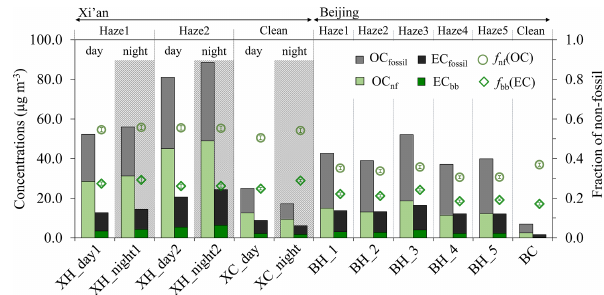
Figure 1. Mass concentrations of OC and EC from fossil and non- fossil sources (OC fossil , OC nf , EC fossil , and EC bb ), as well as frac- tion of non-fossil carbon in OC and EC ( f nf (OC) and f bb (EC), re- spectively), for daytime and nighttime PM 2 . 5 samples in Xi’an and 24h integrated PM 2 . 5 samples in Beijing during haze and clean pe- riods during the measurement periods (2 December 2016 to 10 Jan- uary 2017). For each city, “haze” and “clean” are used to represent high and low pollution events, and clean days at each site are defined as days with PM 2 . 5 less than the median concentration in the winter heating season from 15 November 2016 to 15 March 2017. Uncer- tainties of 14 C-apportioned f nf (OC) and f bb (EC) are indicated but are too small to be visible. The data are shown in Table